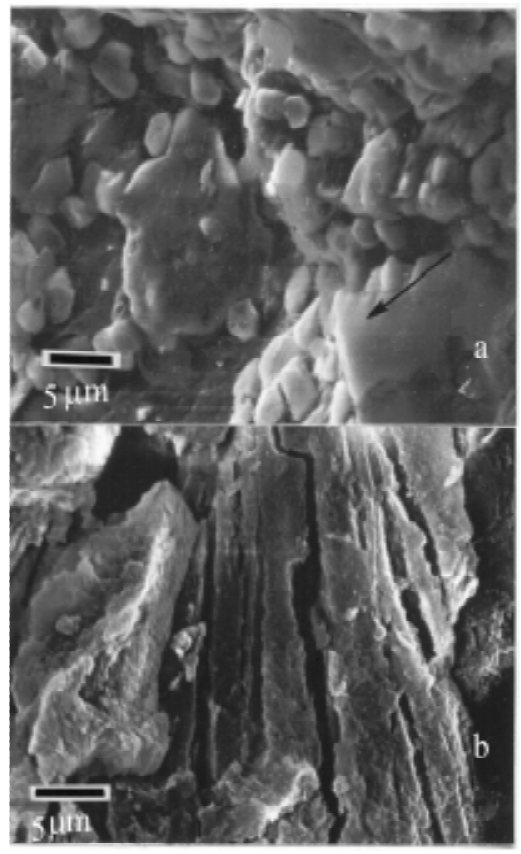
Figura 4. Fotomicrografia eletrônica de varredura de ácidos húmicos extraídos de composto de resíduo sólido urbano (a) e de lodo da estação de tratamento de esgoto (b). A seta em (a) indica o início de desenvolvimento de estrutura laminar nos